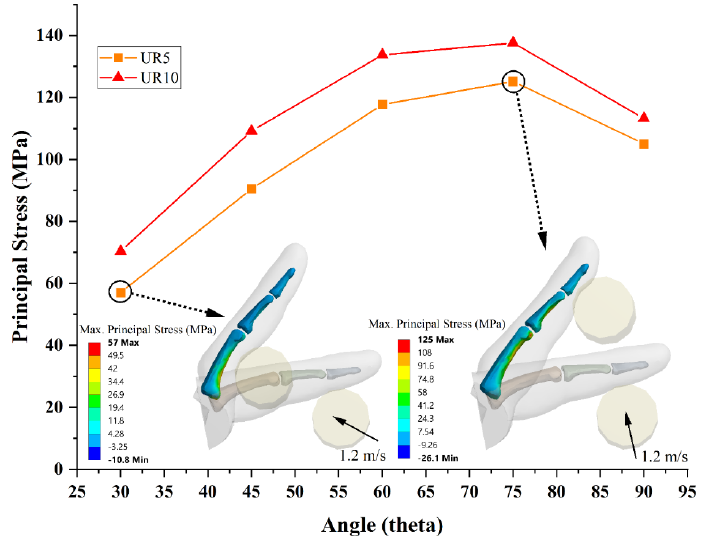
Figure 7. Maximum Principal Stresses vs. Angle of Impact, UR5 and UR10, with contour results at the points shown.